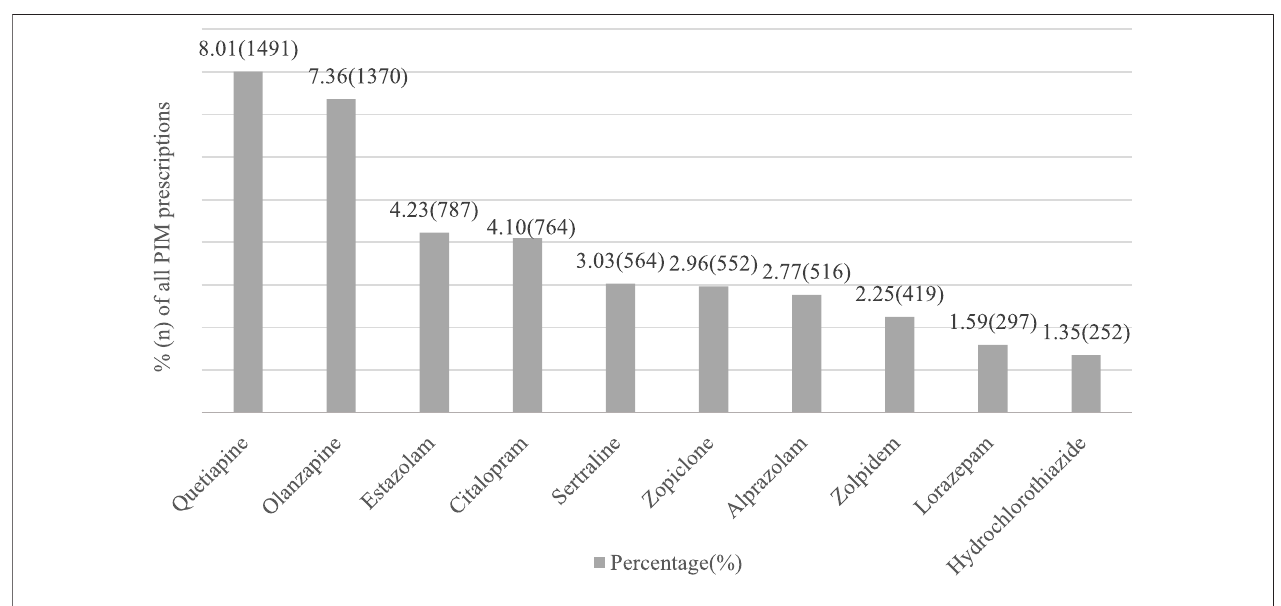
FIGURE 2 | Ten most frequently prescribed PIMs among older outpatients with dementia in China.